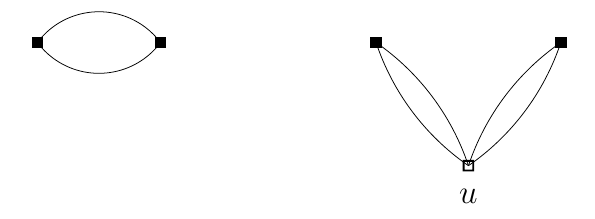
Figure 16 . Leading contributions to the double-trace in a non-Gaussian